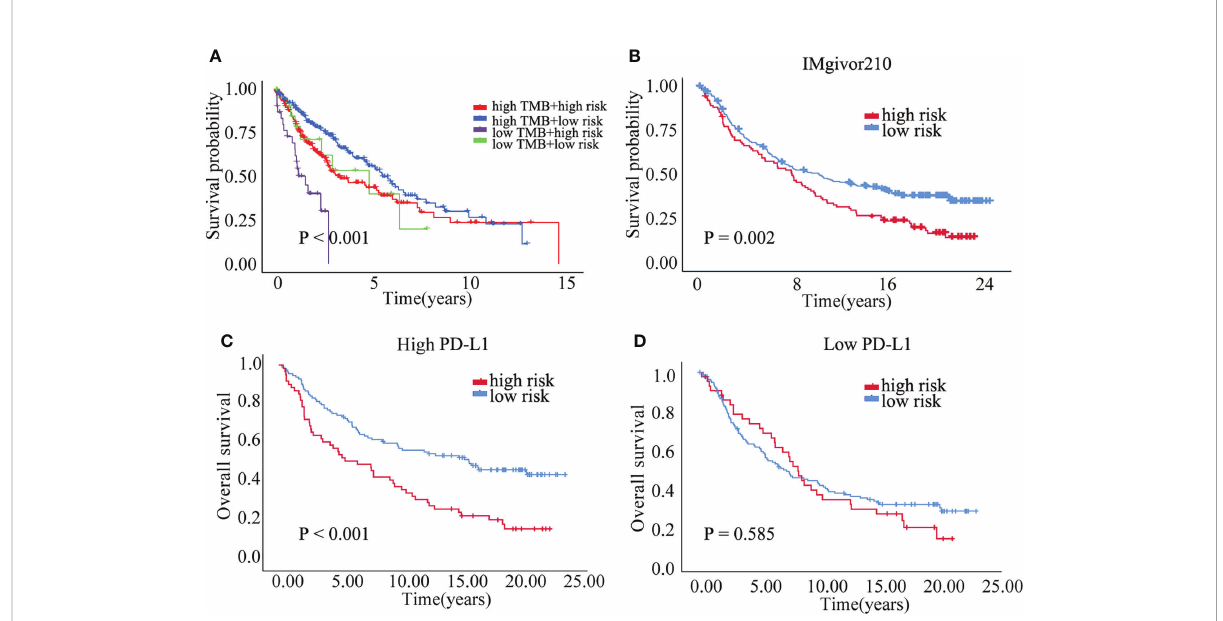
FIGURE 7 The prognostic of risk model. (A) The survival crosstalk between the risk score and TMB. (B) The prognosis between high and low risk group in IMvigor210 cohort. (C) The overall survival of high and low risk group in PD-L1 high expression group. (D) The overall survival of high and low risk group in PD-L1 low expression